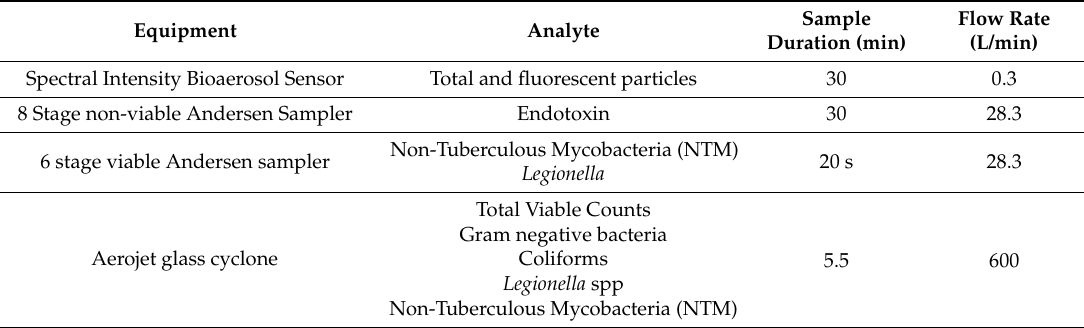
Table 1. Instrumentation used in the chamber.